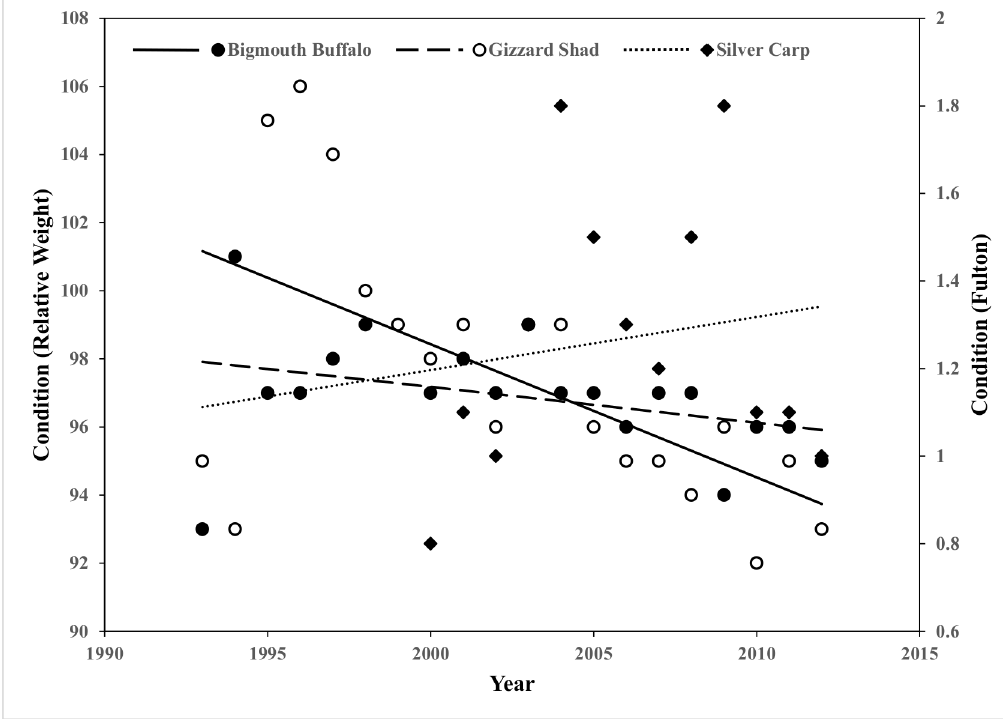
Fig 2. Condition indices and Fulton’s condition factor. Conditionindices(i.e., relativeweight [BigmouthBuffalo and Gizzard Shad] and Fulton’s conditionfactor [Silver Carp]) computed in the lower most reach (Open River, Cape Girardeau, Missouri, RKM 47–129)of the MississippiRiver from